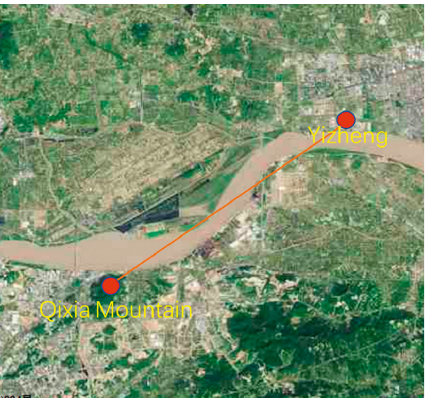
Figure 1: Experimental equipment and the distribution of the MLs.